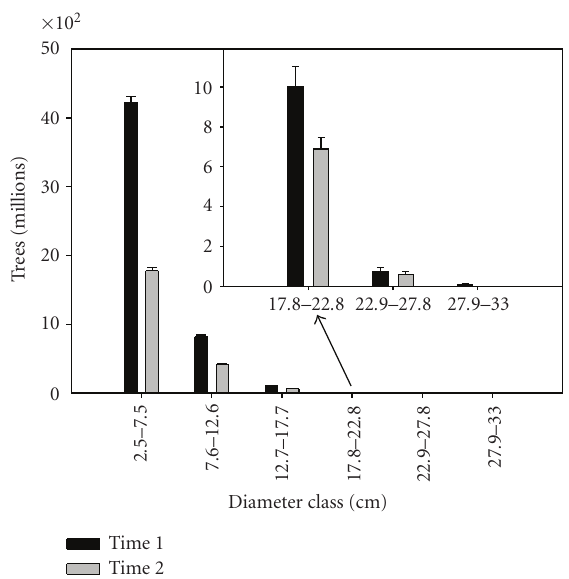
Figure 2: Estimated dogwood populations for the Appalachian ecoregion for times 1 and 2 by diameter